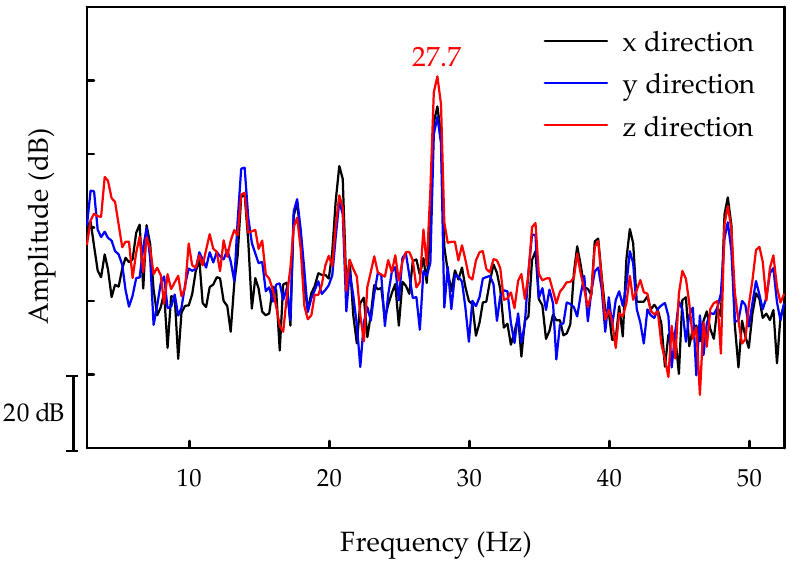
Figure 4. Frequency spectra of the vibration signals at the driver’s seat on the body floor.